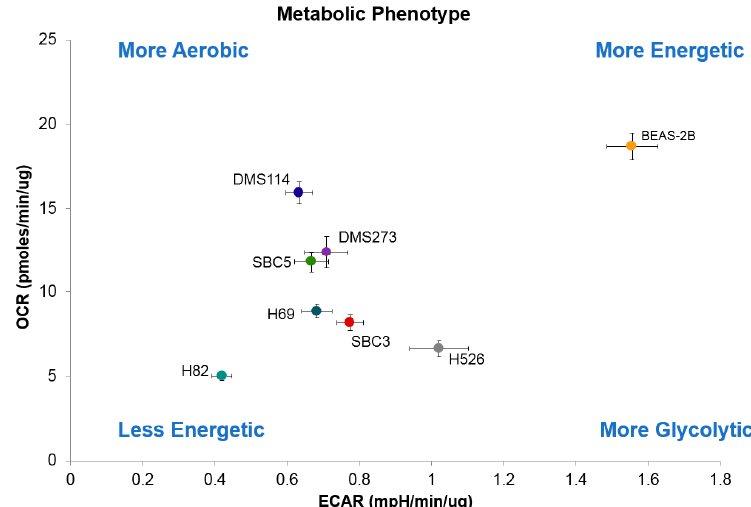
Figure 5. Bioenergetic profile of small cell lung cancer cell lines. Panel shows the ratios of OCR to ECAR in SCLC cells lines. A lower ratio indicates cells are more dependent on glycolysis compared to oxidative phosphorylation. Results are shown as the mean ± SEM of three independent experiments and were analyzed via ANOVA with Tukey’s post-test (* p < 0.05, ** p < 0.005, *** p < 0.0001).